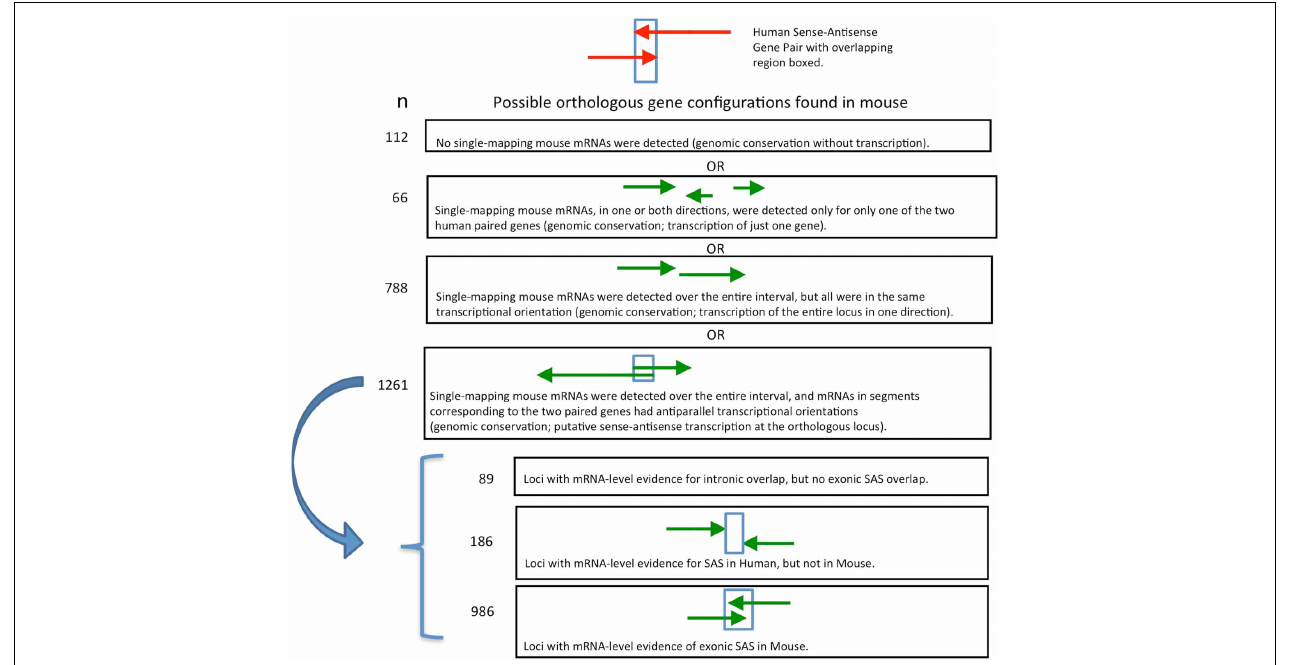
FIGURE 3 | Genomic structure conservation at 986 SAS pairs putatively orthologous between human and mouse.